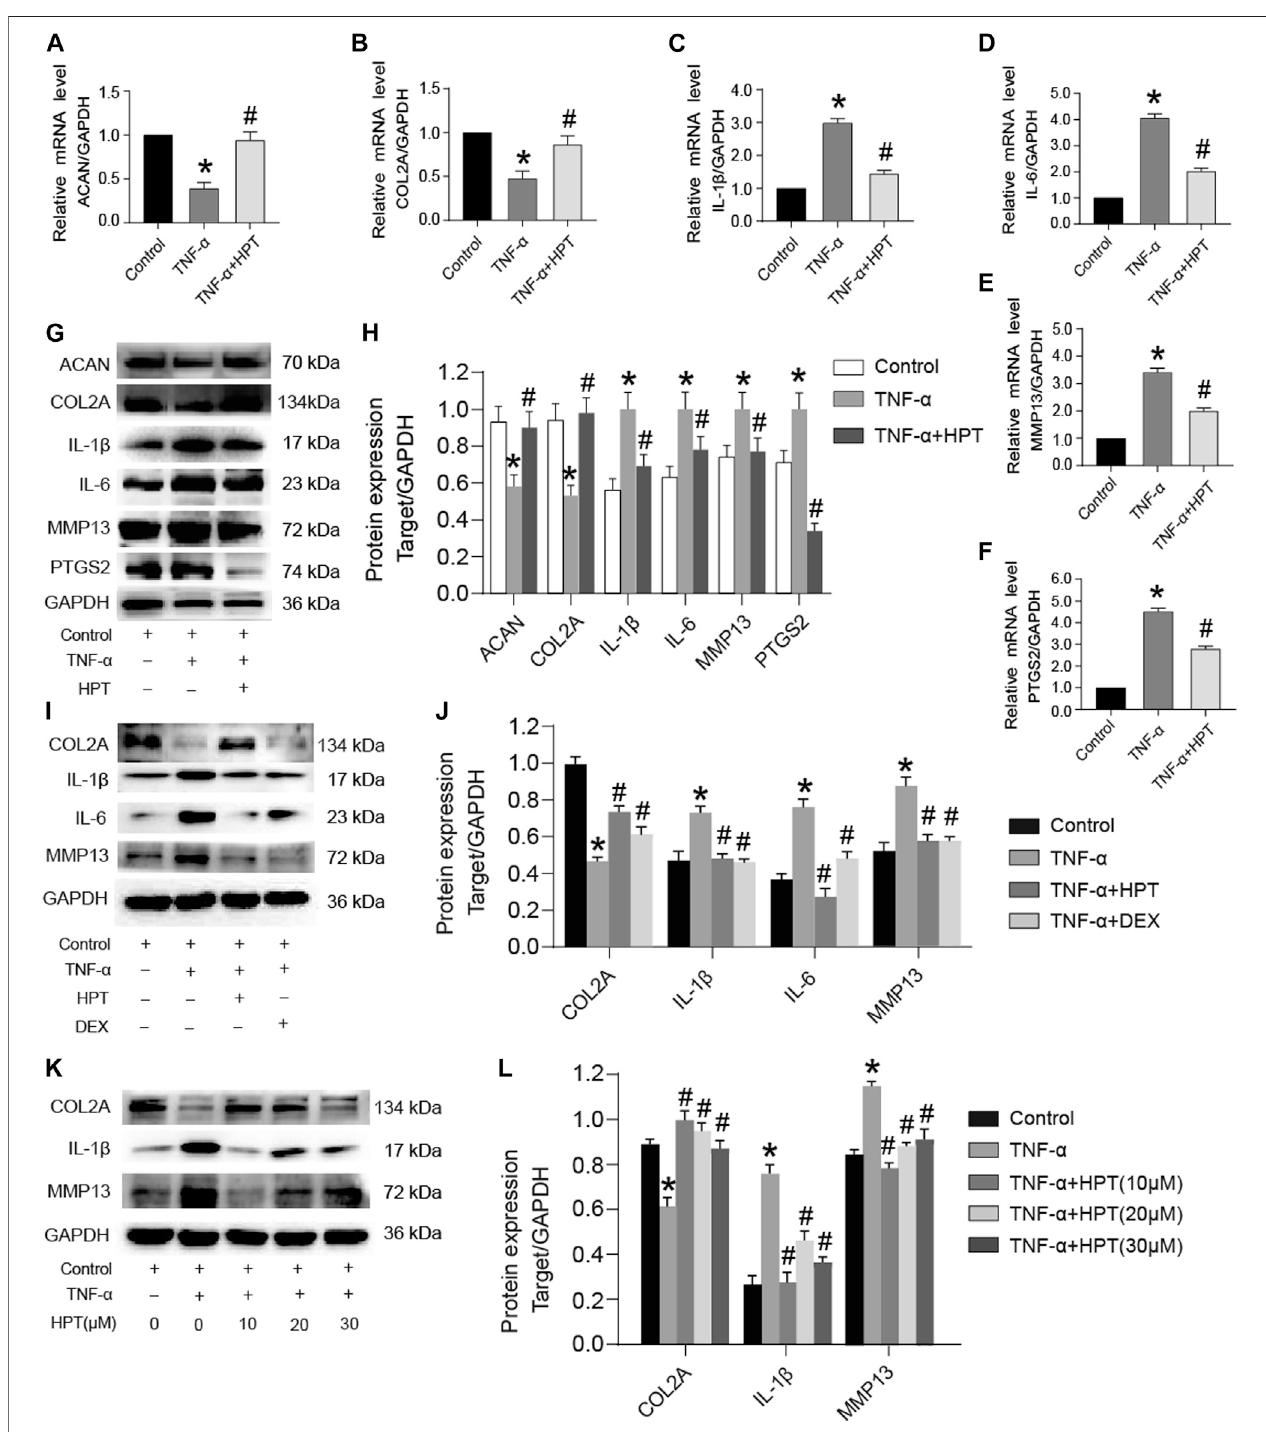
FIGURE 2 | HPT recovered TNF- α -induced abnormal expression of genes and proteins. (A – F) After stimulated chondrocytes with TNF- α and then treated them with or without 10 μ M HPT for 48 h, the mRNA expression levels of ACAN, COL2A, IL-1 β , IL-6, MMP-13, and PTGS2. (G, H) After stimulated chondrocytes with TNF- α and thentreatedthemwithorwithout10 μ MHPTfor48 h, theprotein expressionlevelsofIL-1 β ,IL-6, PTGS2and (cartilage matrixmarkers) COL2A,ACAN, MMP13. (I, J) After stimulated chondrocytes with TNF- α and then treated them with/without 10 μ M HPT or DEX for 48 h, the protein expression levels of IL-1 β , IL-6, and (cartilage matrix markers) COL2A and MMP13. (K, L) After stimulated chondrocytes with TNF- α and then treated them with or without 10, 20, and 30 μ M HPT for 48 h, theproteinexpressionlevelsofIL-1 β and(cartilagematrixmarkers)COL2AandMMP13.AccordingtotheintensityofsemiquantitativeIODthroughtheImageJsoftware, * p < 0.05 was considered as a signi fi cant difference from the control group; # p < 0.05 was considered as a signi fi cant difference from TNF- α .